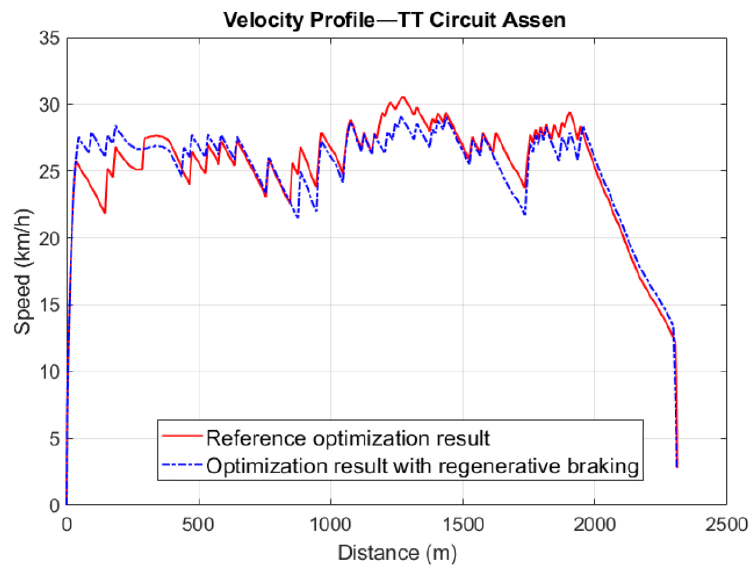
Figure 13. Velocity profile of the optimized driving strategy for the track at